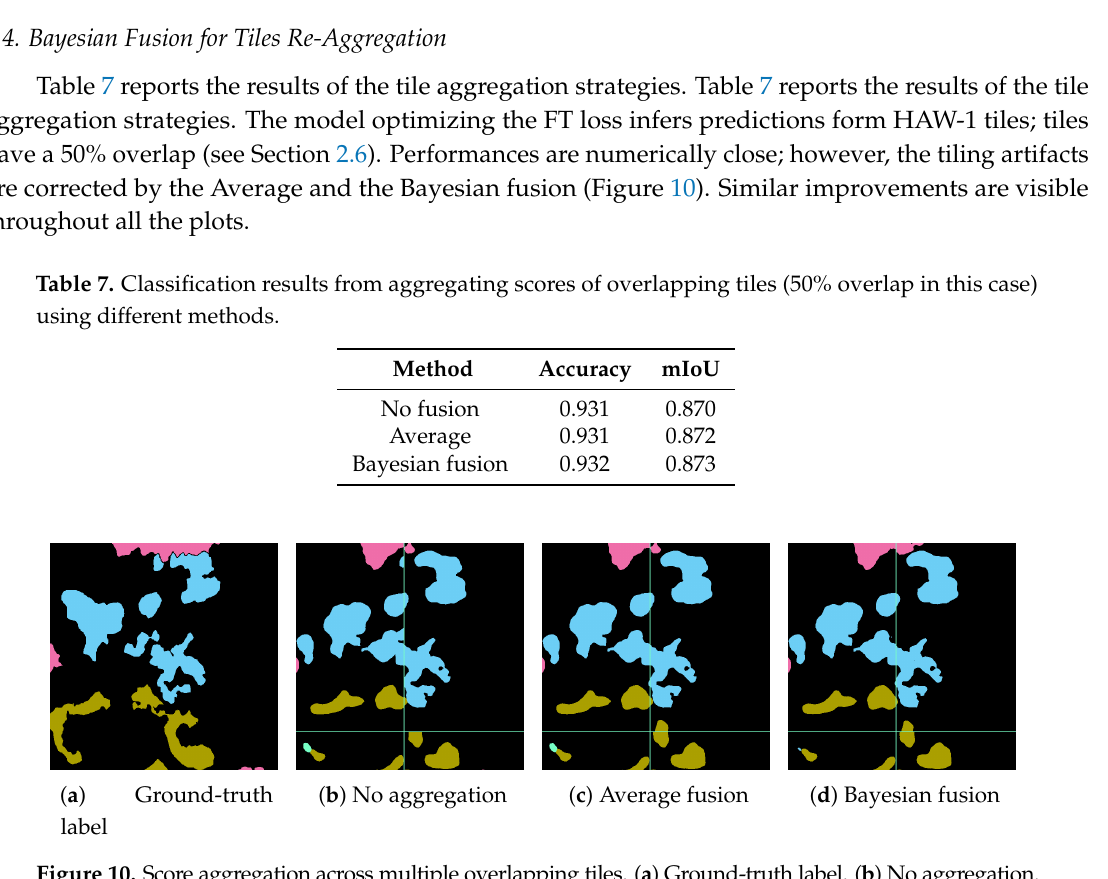
Figure 10. Score aggregation across multiple overlapping tiles. ( a ) Ground-truth label. ( b ) No aggregation. ( c ) Average fusion. ( d ) Bayesian fusion. Without assembly, the classification results on tile borders (highlighted in light green) can be inconsistent, producing tiling artifacts ( b ). The Bayesian fusion ( d ), as well as the average aggregation ( c ), mitigate the problem making the final labeling closer to the ground truth ( a ). The prior knowledge of the predicted class frequencies does correct small classification errors. On the bottom-left of ( d ) there is a reduction of the light green class